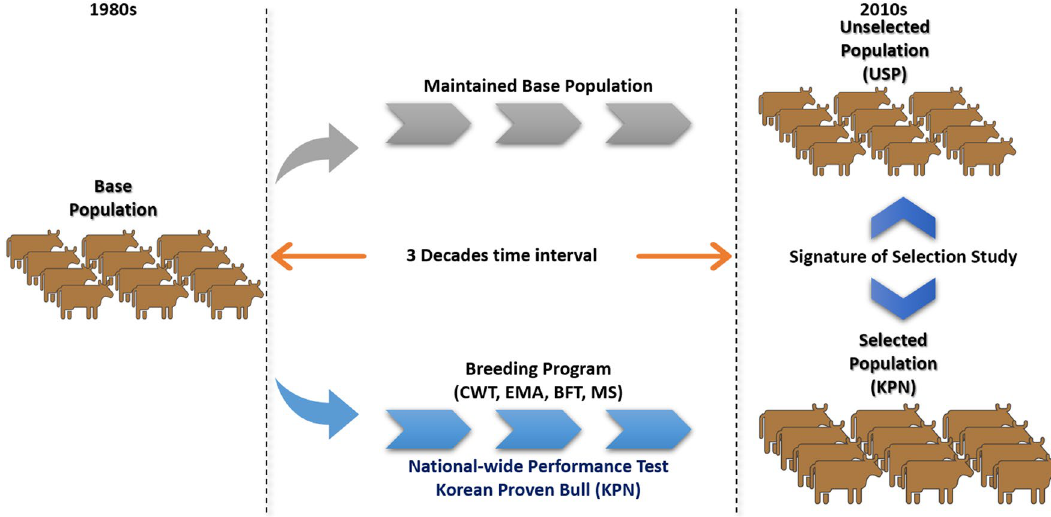
Figure 1. Schematic diagram of selected (KPN) and unselected (USP) Hanwoo cattle populations in